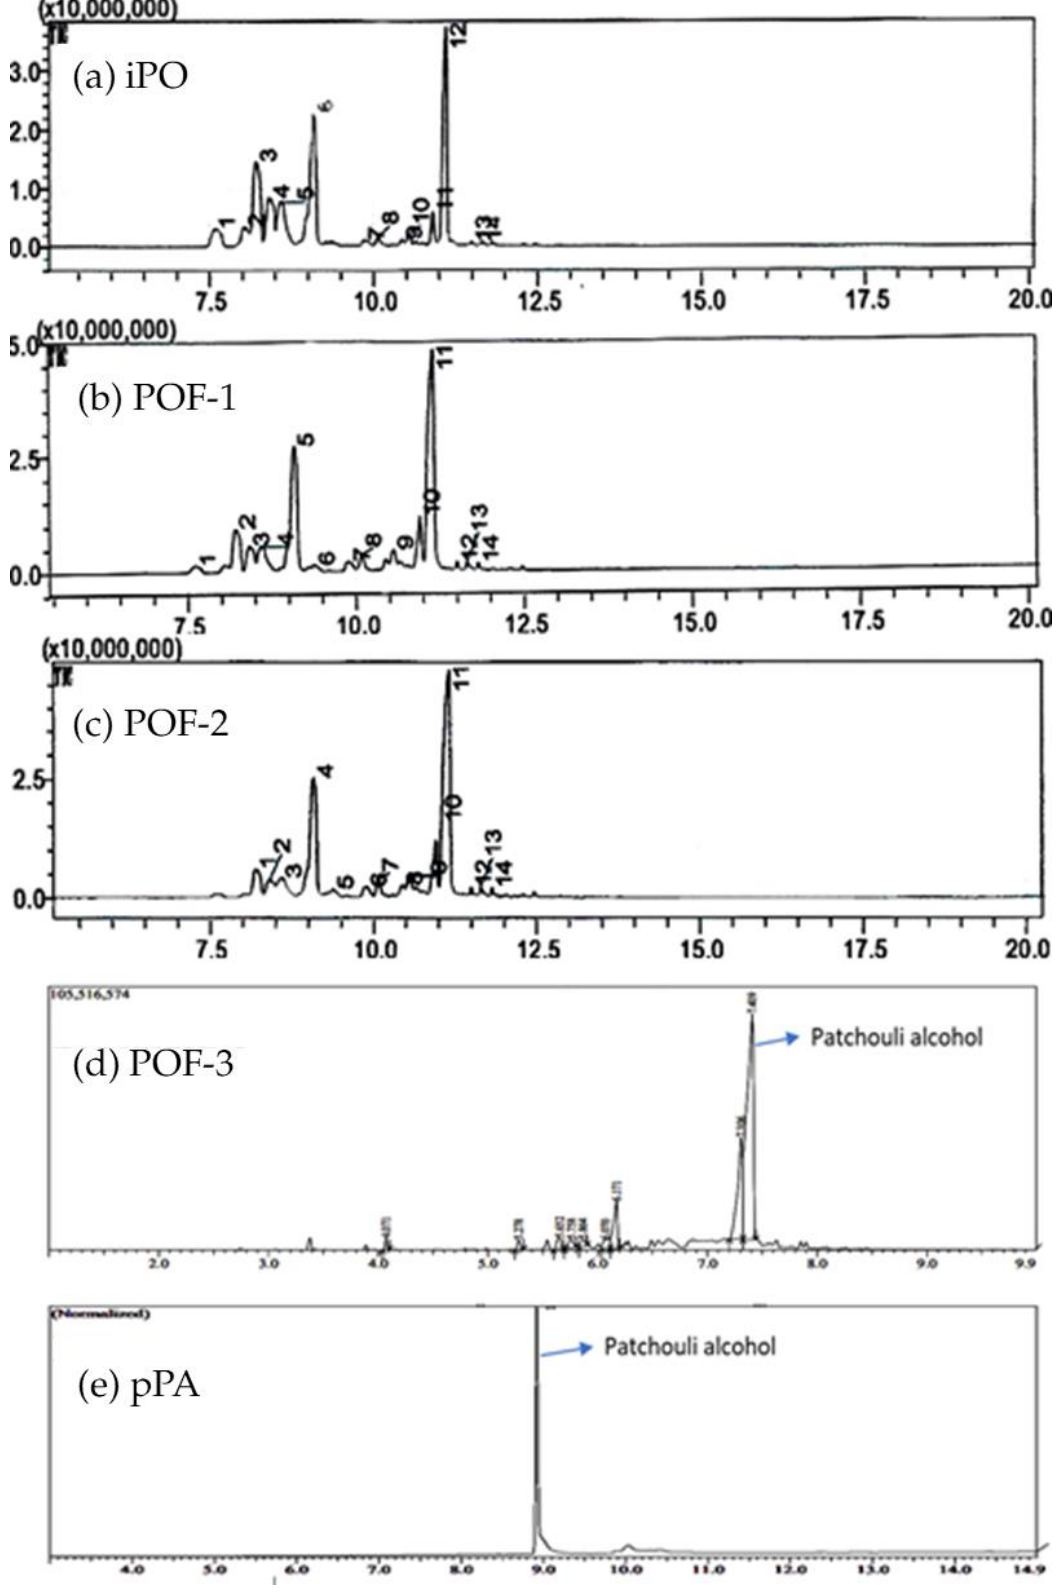
Figure 1. GC-MS chromatogram of iPO ( a ), POF-1 ( b ), POF-2 ( c ), POF-3 ( d ), and (pPA) ( e ).